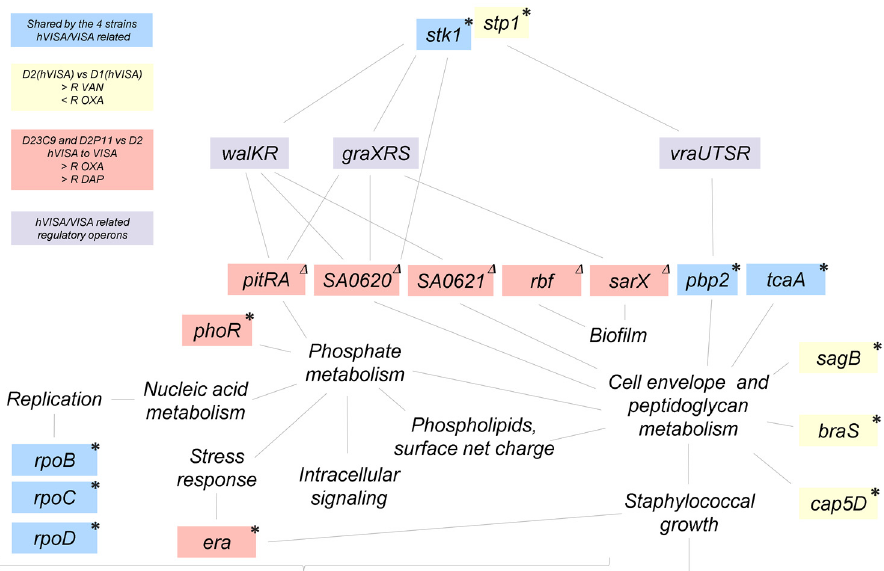
Figure 5. Genes harboring genetic changes in hVISA/VISA strains analyzed in this study and their relationships with cellular processes (lines). Blue boxes: Genes with mutations related to hVISA/VISA shared by D1, D2, D23C9 and D2P11. Yellow boxes: Genes with mutations differing between D2 and D1. Red boxes: Genes differing between the in vitro-selected mutants (D23C9 and D2P11) and their parental strain (D2). ∆ ≈ 8 kb IS 256 -mediated deletion. * SNP/INDEL. Purple boxes: Key regulatory operons related to vancomycin resistance in hVISA/VISA (not mutated in these strains). R: Resistance. VAN: vancomycin. OXA: oxacillin. DAP: daptomycin.